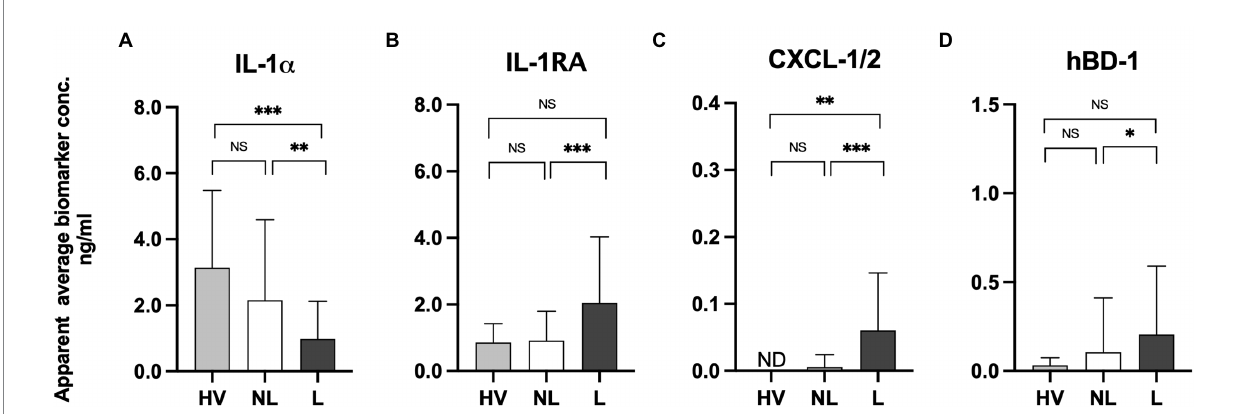
FIGURE 1 (A) Measurements of IL-1 α , IL-1RA, CXCL-1/2, and hBD-1 on lesional and non-lesional skin of psoriasis patients and normal skin of healthy volunteers using the FibroTx TAP. The apparent average biomarker concentrations of IL-1 α IL-1RA, CXCL-1/2, and hBD-1 detected from the skin surface of 10 healthy volunteers (grey bars), on non-lesional skin (NL; white bars) and lesional skin (L; black bars) of 30 psoriasis patients have been plotted. Y -axis: Apparent concentration of analyzed biomarker on the skin in ng/mL. X -axis: sampling site. Error bars on graphs present the standard deviations from the average of combined measurements of the participants. Statistical significance is indicated on panels (A–D) : * p < 0.05, ** p < 0.01, *** p < 0.001; NS- not significant.